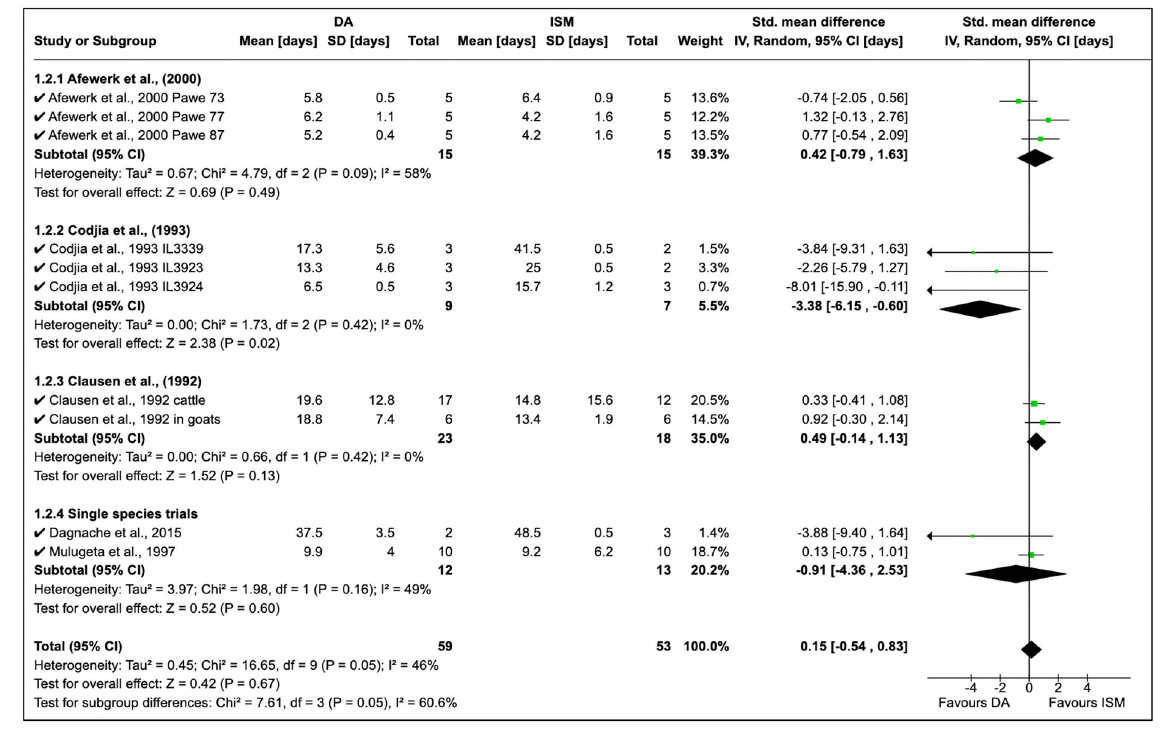
FIGURE3 Mean relapse time in preclinical trials with diminazene aceturate and isometamidium